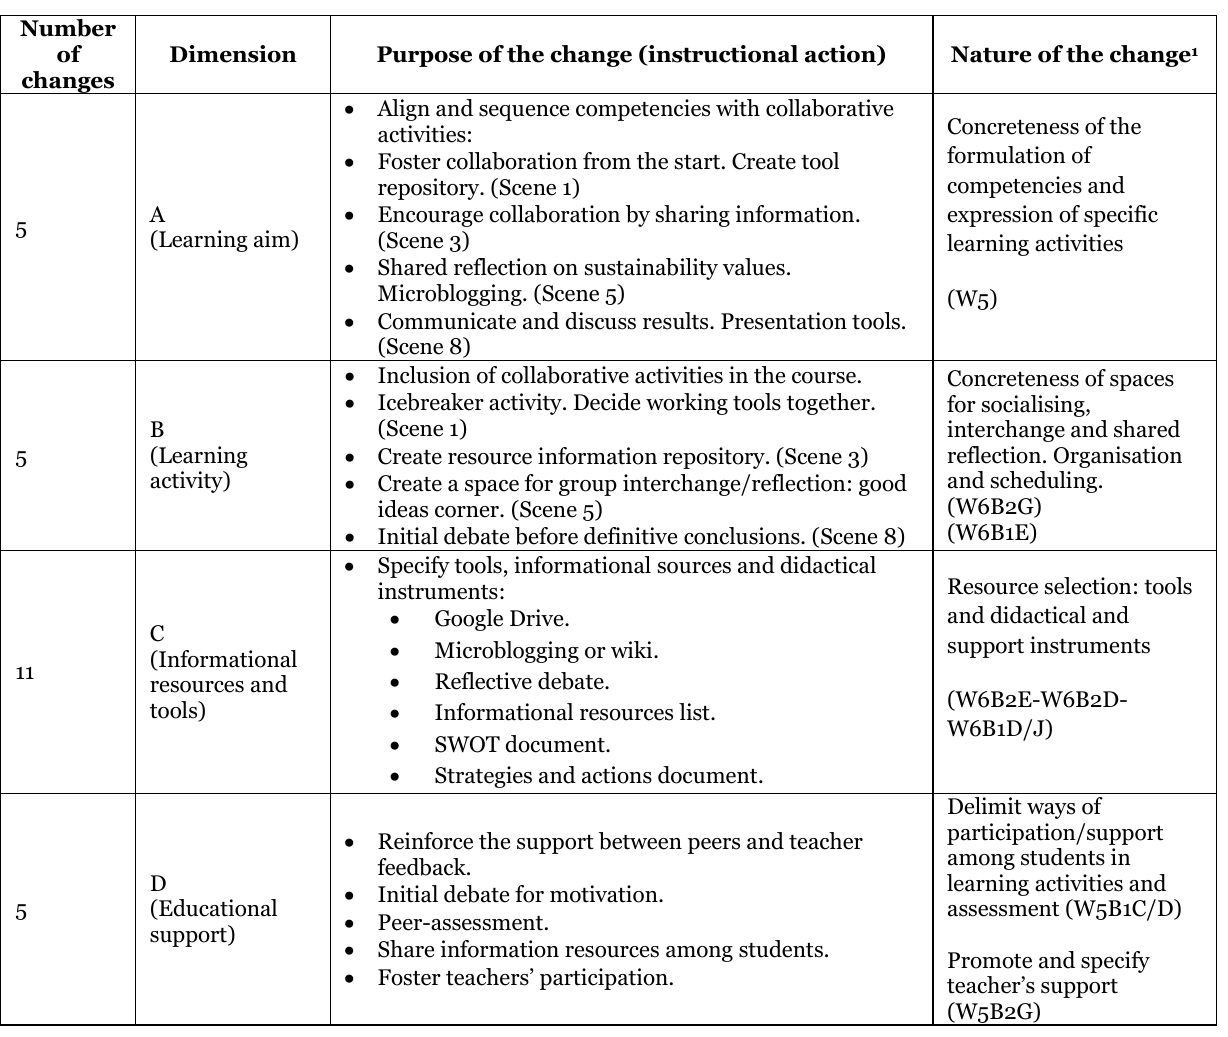
Summary of Changes From V1 to